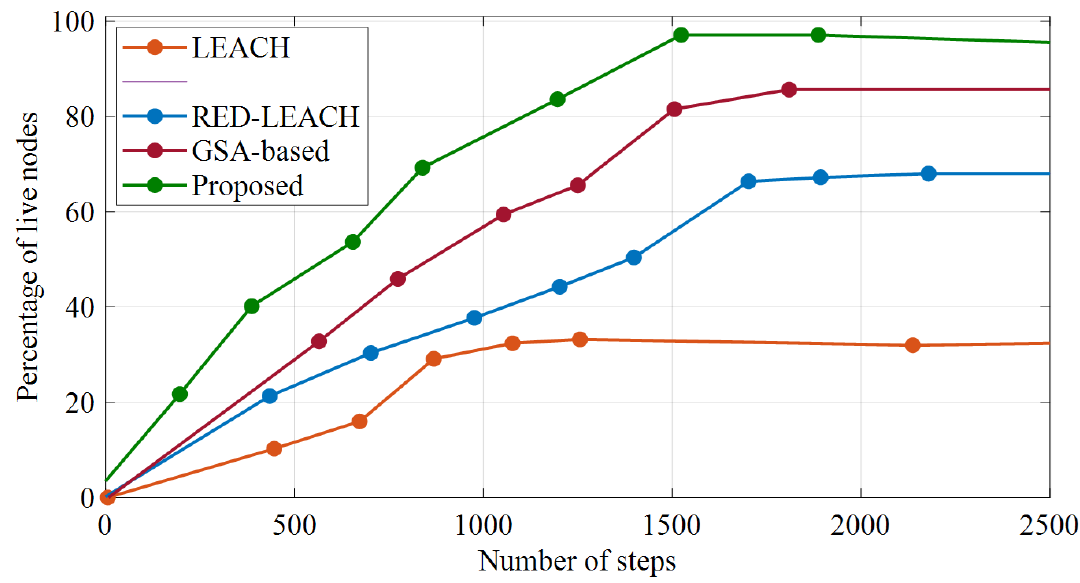
Figure 8. Throughput-sent packets to the sink.